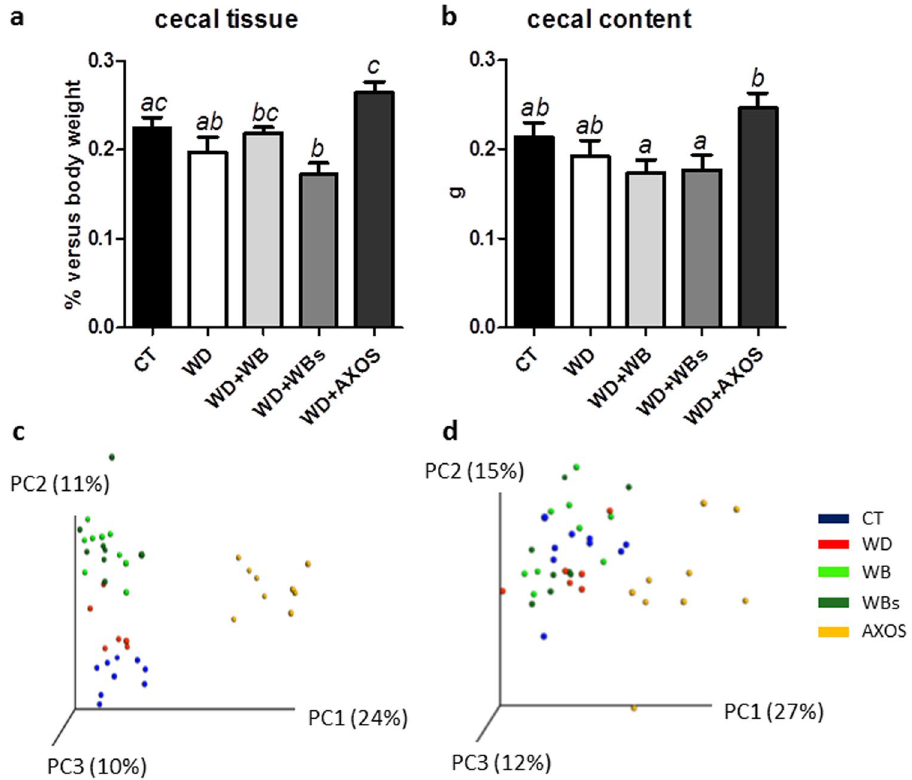
Figure 1. Impact of the three cereal fractions on the gut microbiota in the cecal content. Weight of cecal tissue ( a ), cecal content ( b ), Principal Coordinate Analysis plot of β -diversity based on Bray-Curtis distance ( c ) and Principal Coordinate Analysis plot of β -diversity based on Morista-Horn distance ( d ). Mice were fed a control diet (CT, blue), a western diet (WD, red), a WD supplemented with 5% of wheat bran fraction with large particles (WD + WB, clear green), a WD supplemented with 5% of wheat bran with reduced particle size (WD + WBs, dark green) or a WD supplemented with 5% of AXOS (WD + AXOS, yellow) for 8 weeks. Results are expressed as mean ± SEM for a and b (n = 7–9). Data with different superscript letters are significantly different at p < 0.05 (ANOVA). Dietary treatments accounted for 39 and 48% of the variation in the dataset (Bray-Curtis and Morisita-Horn respectively, adonis method, 1000 permutations, p <